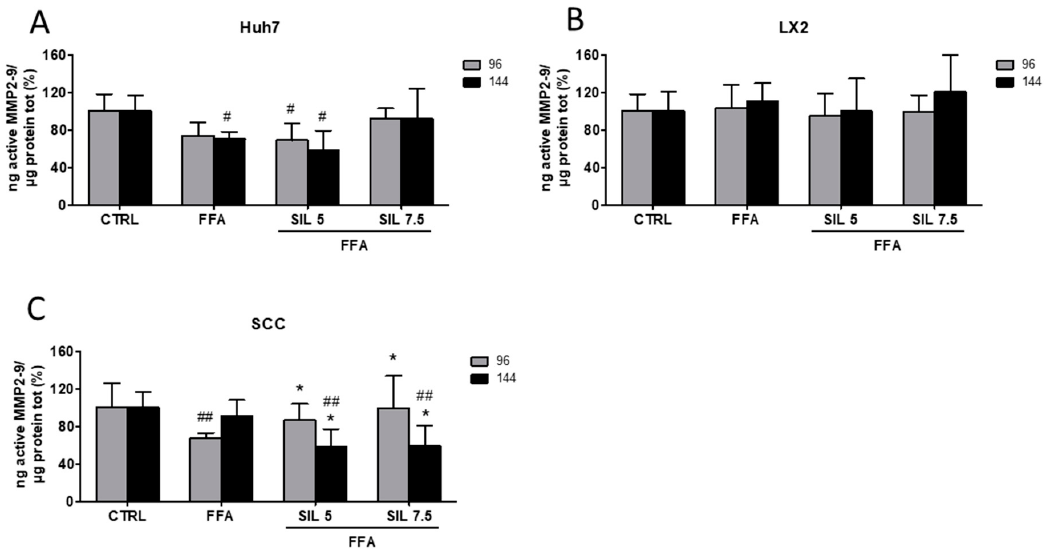
Figure 3. MMP2-9 activity. Enzymatic activity of active MMP2-9 was analyzed in the supernatant of Huh7 ( A ), LX2 ( B ), and SCC ( C ) treated with free fatty acids (FFAs) and Silybin for 96 and 144 h. Activity was normalized to the total proteins in the cell lysate and reported as percentage vs. CTRL sample. # p < 0.05, ## p < 0.01 vs. CTRL; * p < 0.05 vs. FFA.